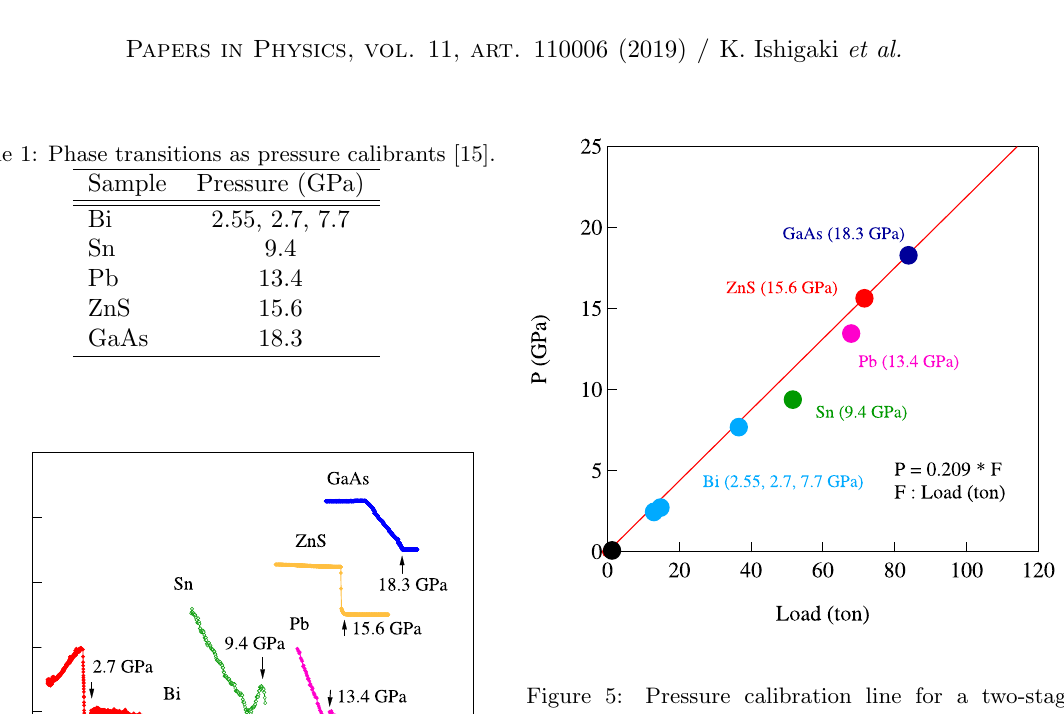
Figure 5: Pressure calibration line for a two-stage multi-anvil high pressure